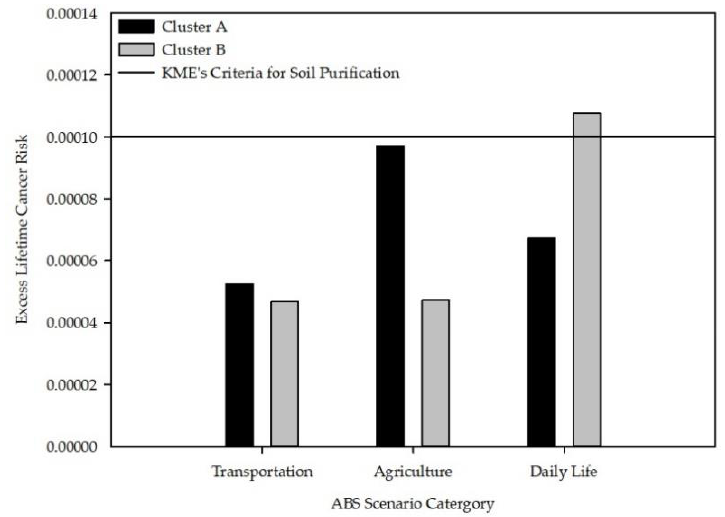
Figure 4. ELCR for health risk assessment of residents near abandoned asbestos mines in South Korea.